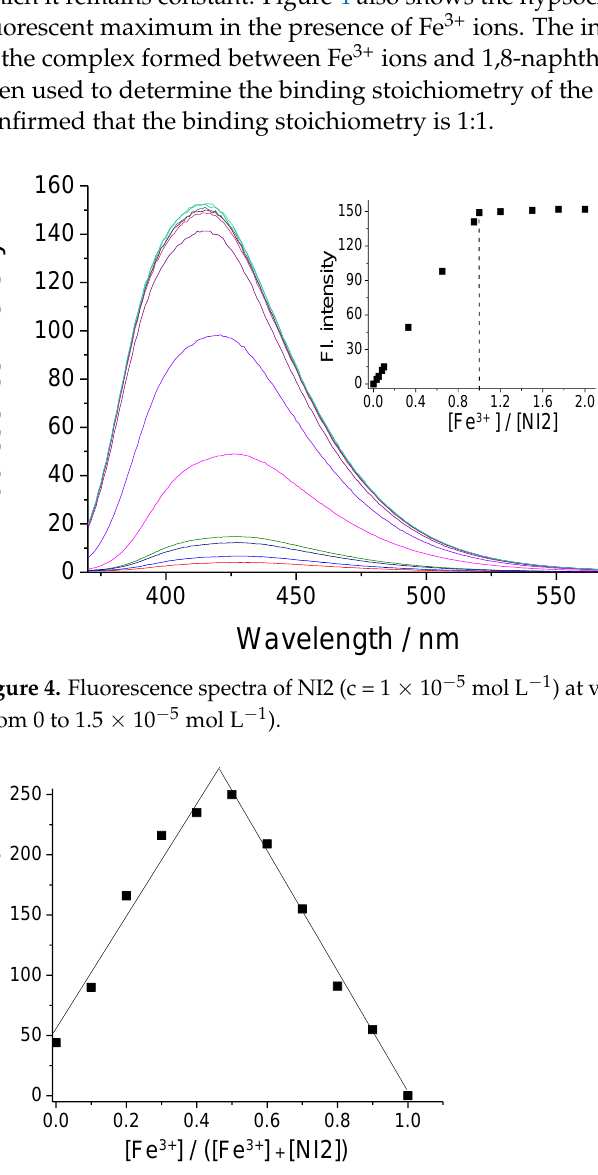
Figure 5. Job’s plot for the Fe 3+ complex of NI2. At the concentration of Fe 3+ ions in the range c = 0–9 × 10 − 6 mol L − 1 , a very good linear dependence was obtained, with R = 0.9999 (Figure 6). Based on the linear regres- sion, the limit of detection LOD = 4.48 × 10 − 7 mol L − 1 and the limit of quantification LOQ = 1.49 × 10 − 6 mol L − 1 were calculated by the following dependencies: LOD = 3Sa/b and LOQ = 10Sa/b, where Sa is the standard deviation of the response and b is the slope of the calibration curve [27]. The values obtained are smaller than the ppm concentration range and are low enough for the detection of Fe 3+ . A similar dependence was obtained when using NI1 as a